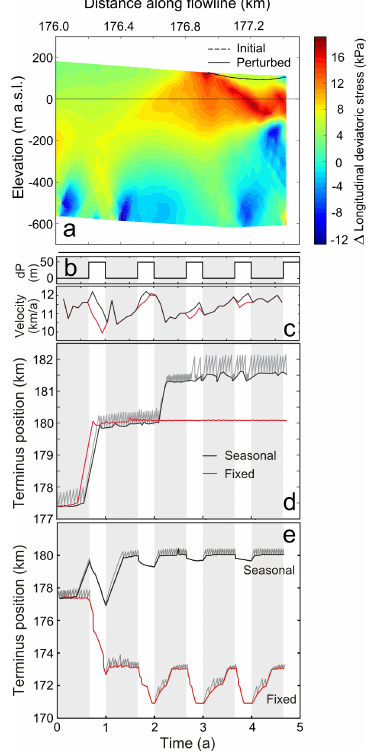
Fig. 4. Results of basal water pressure experiments. (a) Change in longitudinal deviatoric stress when a change in hydrostatic head at the bed of 50m is applied (first timestep). The base of the crevasse field is almost identical in both the initial and perturbed experiments. (b) Seasonally applied change in basal water pressure. (c) Resultant change in surface velocity at calving front. (d) Evo- lution in terminus position with fixed and seasonally varying basal water pressure. (e) Repeat of results shown in (d) but with an addi- tional seasonal change in cwd of 30m. Grey lines show the continu- ous terminus position, while darker lines show the terminus position after each calving event to highlight overall